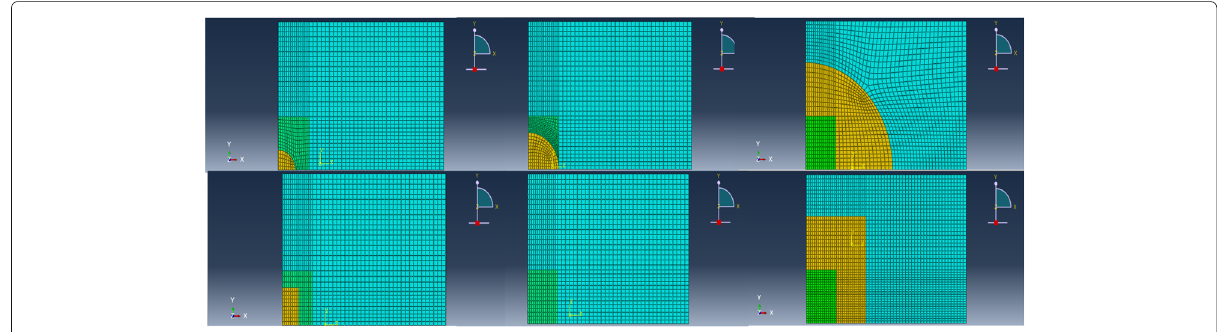
Fig. 3 Plan view of six cyclic loading models